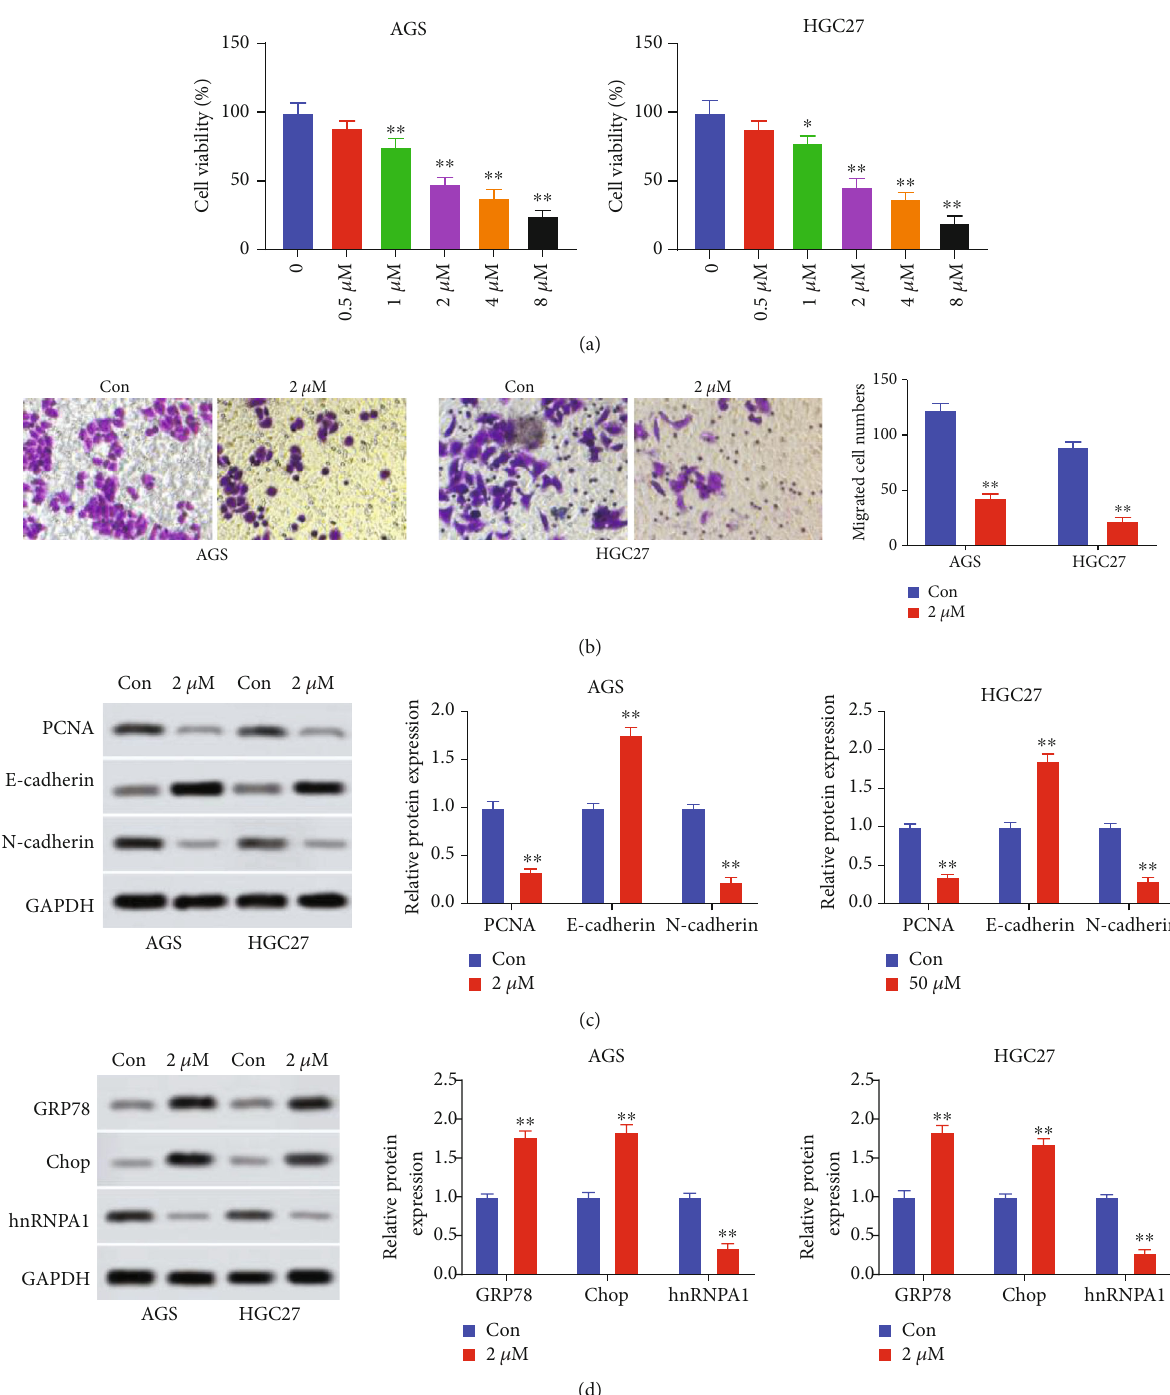
Figure 1: Asiaticoside suppresses aggressive behaviors and induced endoplasmic reticulum stress in gastric cancer. (a) Cell viability of AGS and HGC27 cells after treatment with AC (0, 0.5, 1, 2, 4, or 8) was determined using the CCK-8 assay. (b) Cell migration of cells after treatment with 2 μ M AC was measured utilizing the Transwell migration assay. (c) The levels of PCNA, E-cadherin, and N-cadherin in AGS and HGC27 cells after treatment with 2 μ M AC were determined utilizing Western blot. (d) The levels of GRP78, Chop, and hnRNPA1 in AGS and HGC27 cells after treatment with 2 μ M AC were determined using Western blot. ∗ P < 0 : 05 , ∗∗ P < 0 : 01